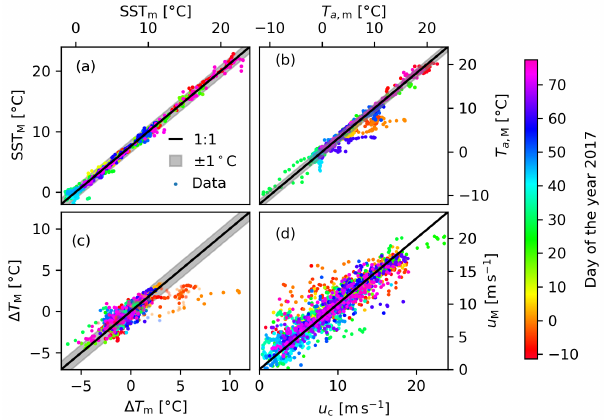
Figure E1. (a) ERA-5 SST against in situ observations of the sur- face water temperature (Haumann et al., 2020). (b) ERA-5 air tem- perature at 2ma.s.l. against T a measured at 23.7ma.s.l. (c) ERA- 5 (cid:49)T against the observed air–water temperature difference. The transparent scatter shows data for which observations of SST where not available. Here, (cid:49)T m was calculated from the observed T a and the SST estimates from ERA-5. (d) u M against u c (31.5m wind speeds). This figure only shows data from legs 1, 2, and 3. All data are displayed as 1h average values. The colour indicates the time of the observations (UTC) provided as day of the year 2017 (the time difference to 1 January 2017 00:00UTC in days). The black line indicates the 1 : 1 line, and the shaded area is the ± 1 ◦ C Figure D1. S m , port S − 1 as function of D m , port . The curves show M the results when ERA-5 observations that could have been affected by the assimilation of the reported wind speed observations were not included (black), were included (brown), or were exclusively used for the estimation of S m , port S − 1 (green). The shaded areas M denote the error of the mean.